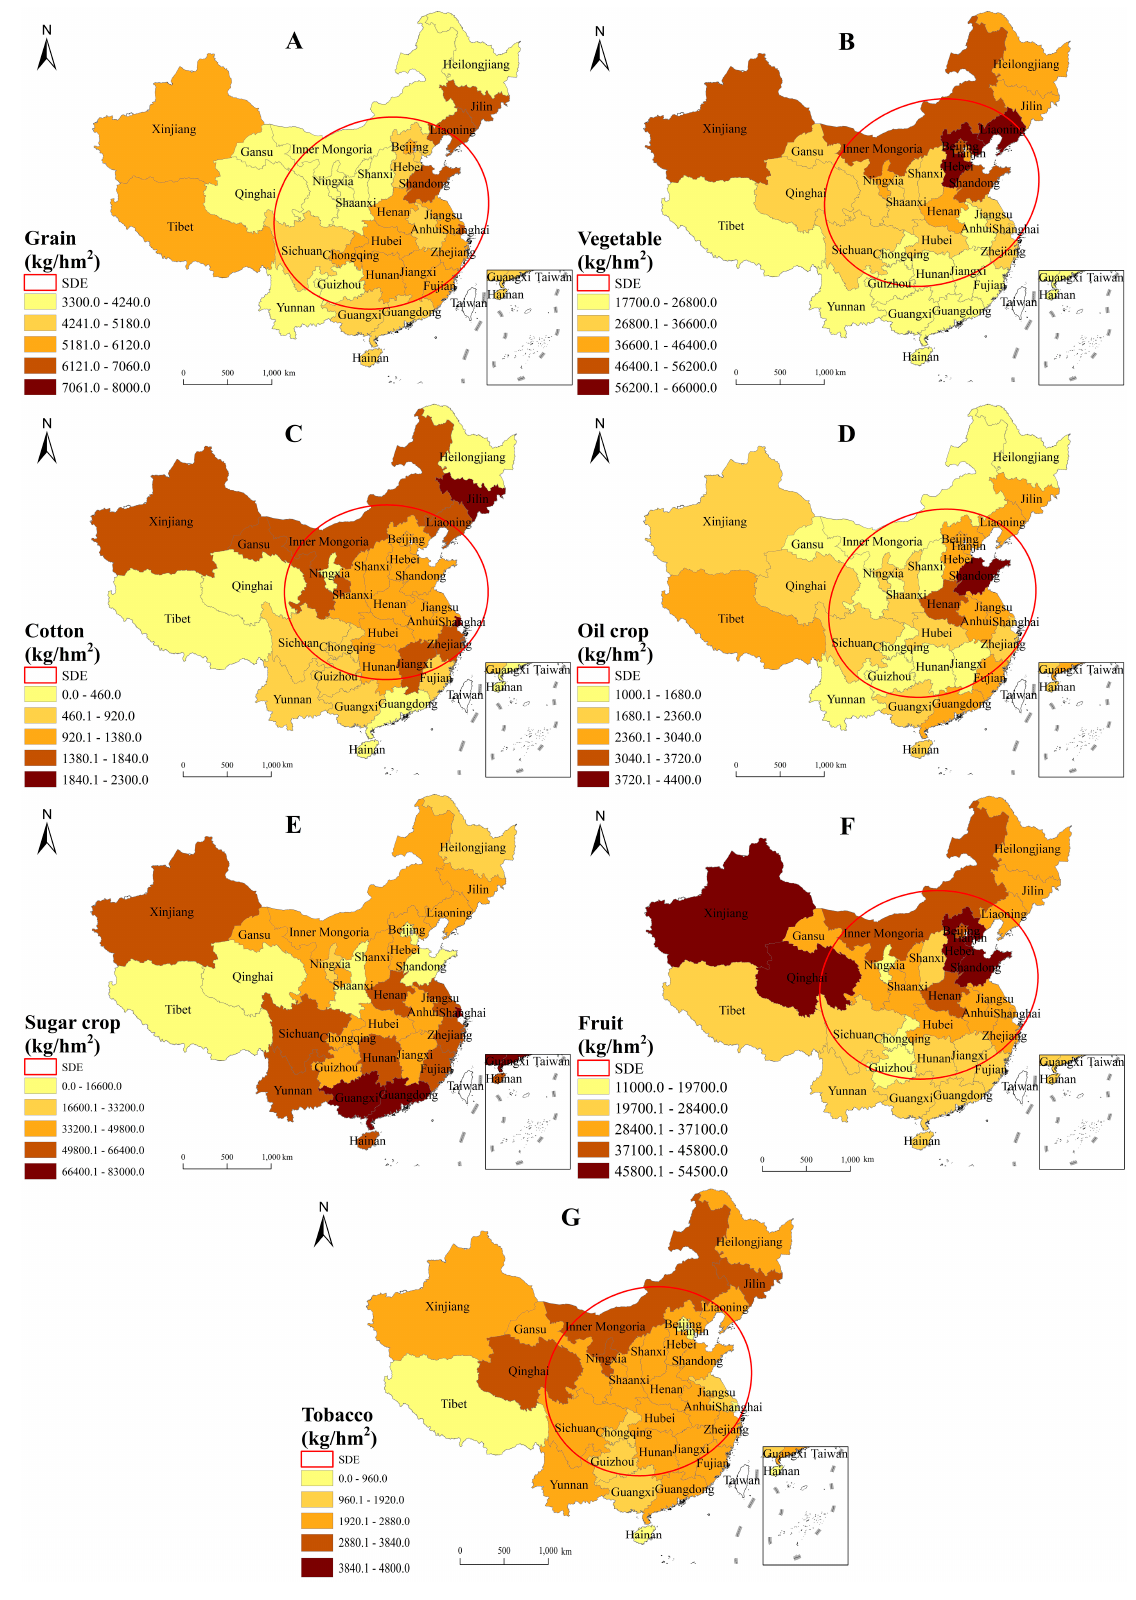
Figure 8. Output on per unit area of arable land in 2008.